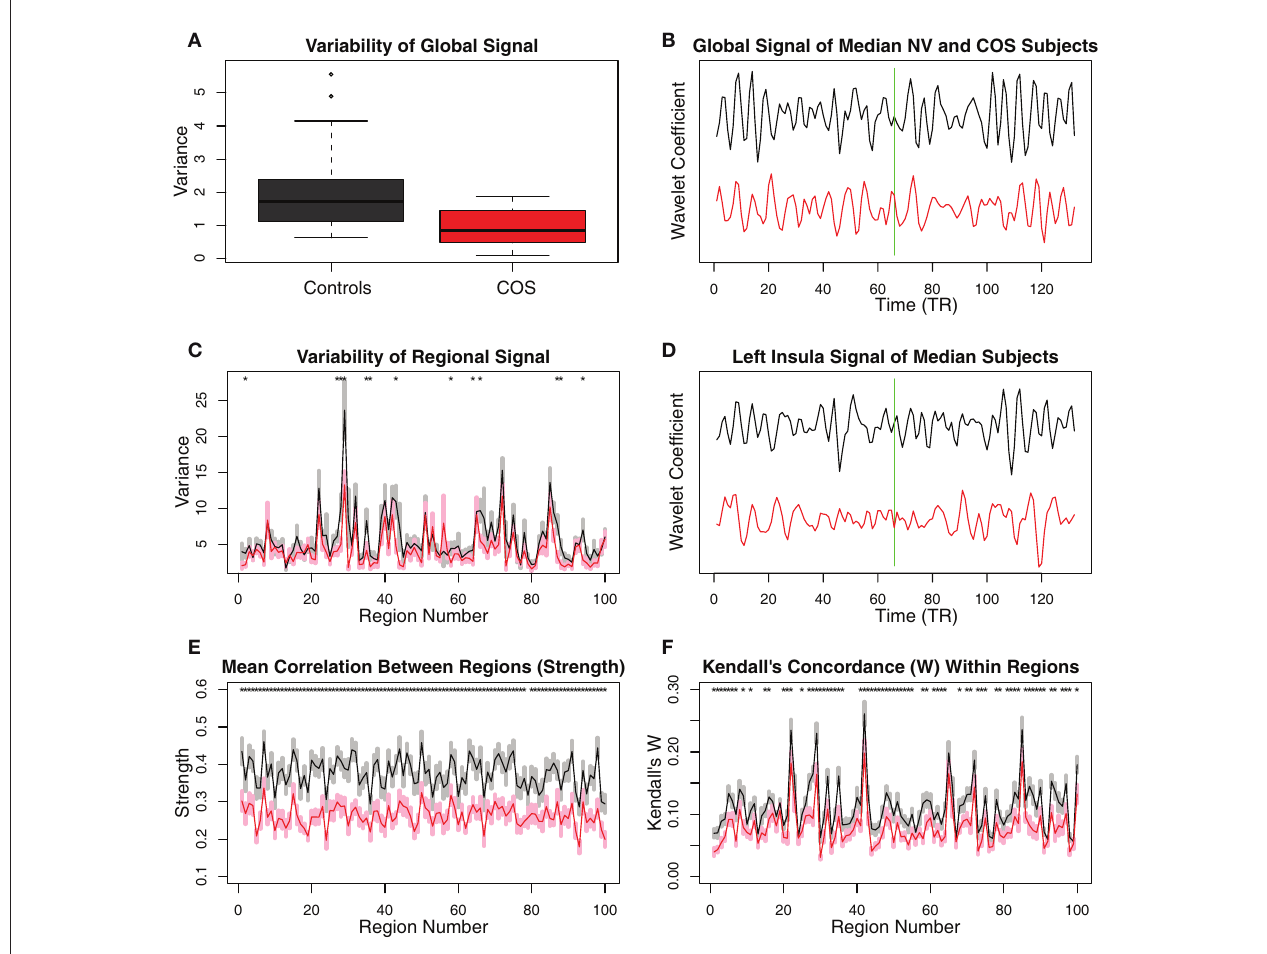
FIguRe 2 | Plots showing differences between the schizophrenic patients and the controls in terms of relatively simple, non-graph-theoretical properties of their MRI time series. (A) The variability in the scale 2 (0.05–0.111 Hz) global MR signal is higher in the controls than in the COS population. (B) The difference in the variability of the global MR signal is illustrated with the time series from the median subjects of each population. The green line shows the boundary between the successive scans, whose wavelet coefficients were concatenated. (C) There is a trend toward greater variability in the MR signal of anatomical regions, in the control population